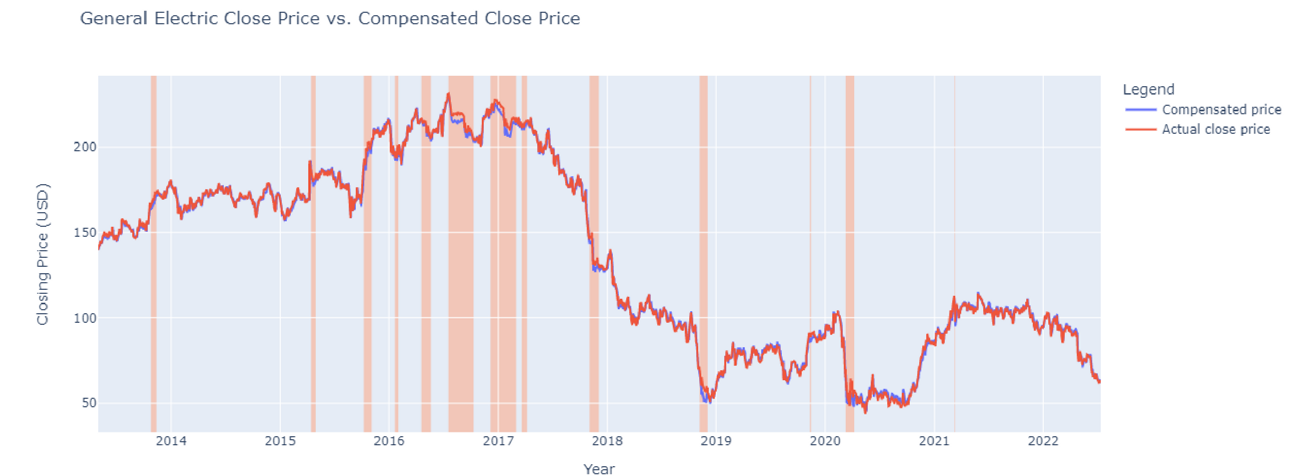
Figure 9. Compensated prediction of the HONN compared to the ground truth stock price with marked anomalous